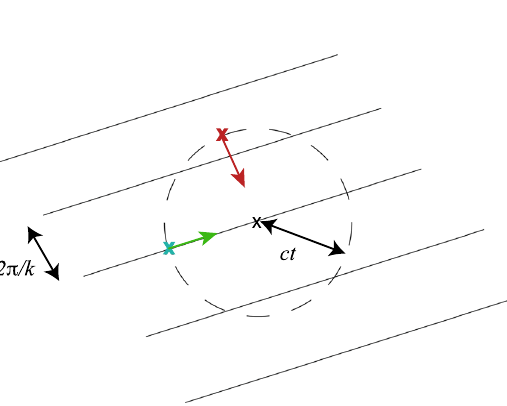
Fig. 3 Left hand side: schematic picture of a perturbation in an equi- librium state that displays sheets of overdensity at wavelength 2 π/ k . For a massless, free streaming gas at time t , the dynamical response at a position x is given by integrating contributions along the circle of